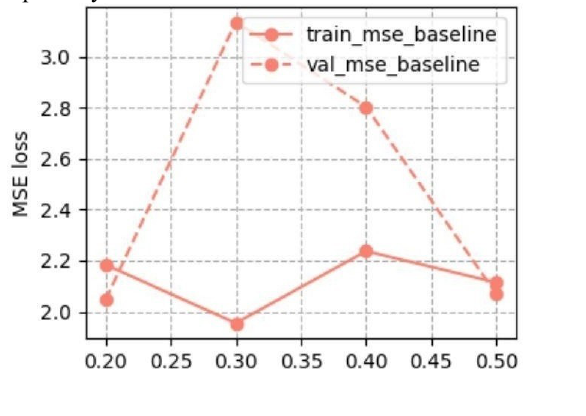
Fig. 5: Dropout Rate Tuning Results